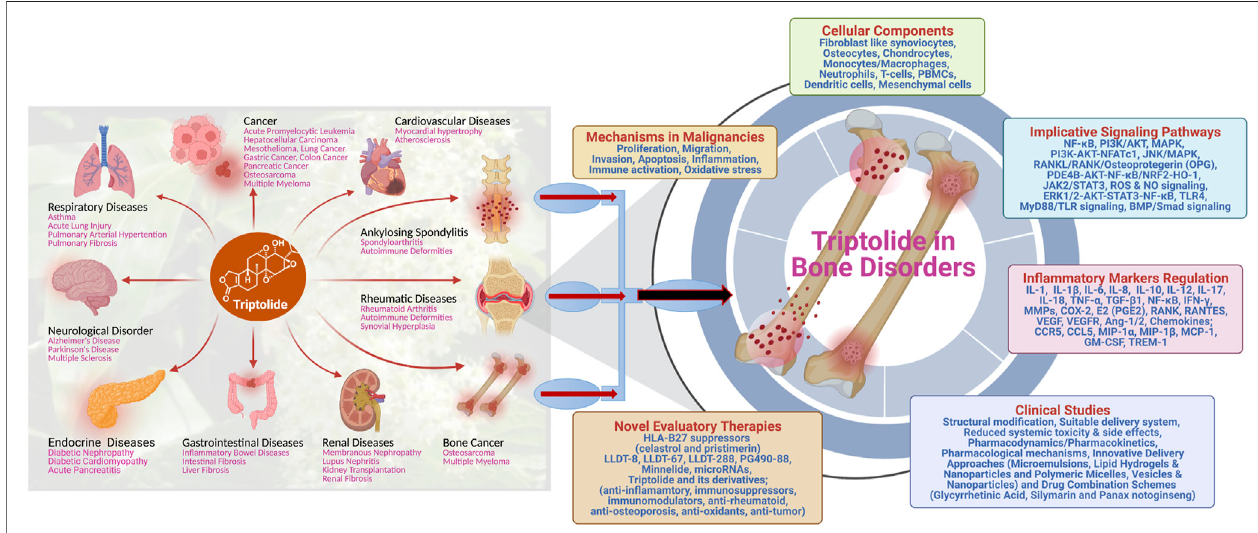
FIGURE 2 | Schematic illustration of the multifaceted role of triptolide in treating different diseases, with exclusive therapeutic potential in treating bone disorders.